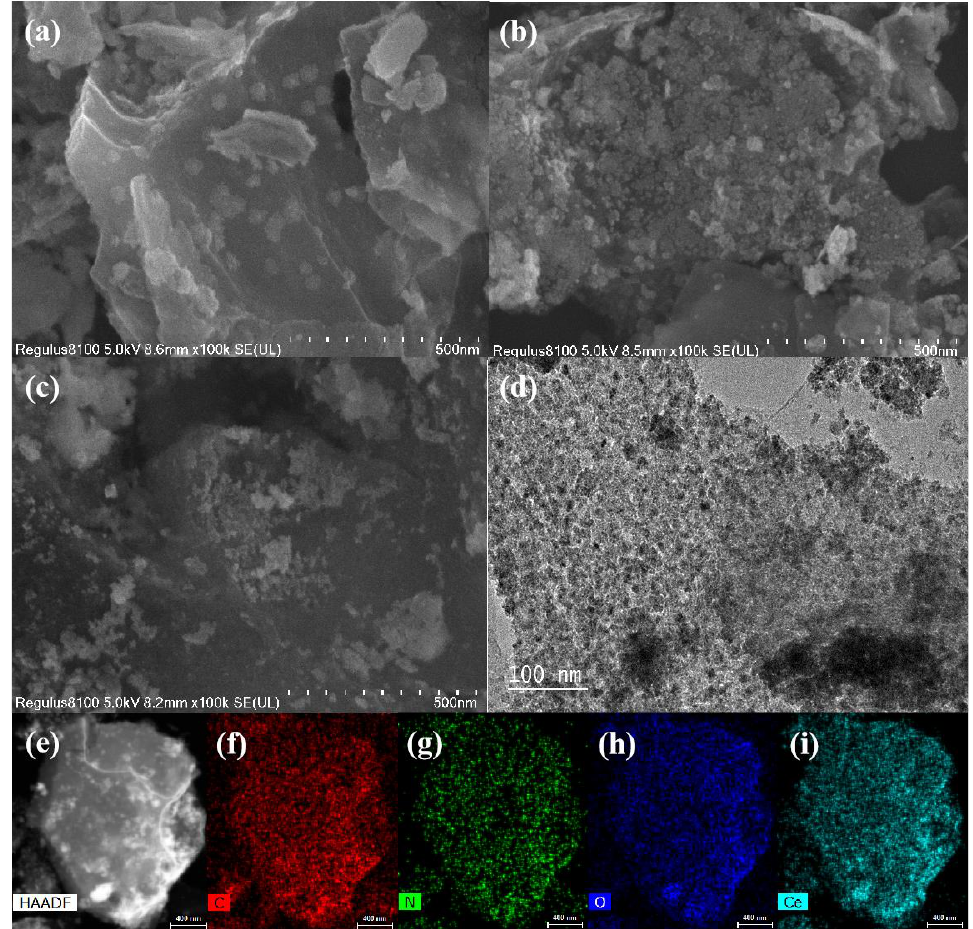
Figure 1. ( a – c ) SEM images of CeO 2 – CN calcined at 600, 800, and 1000 ℃ , respectively. ( d ) TEM image of CeO 2 – CN calcined at 800 ℃ . ( e – i ) High-angle annular dark field image and corresponding elemental mappings of CeO 2 – CN for C, N, O, and Ce, respectively.